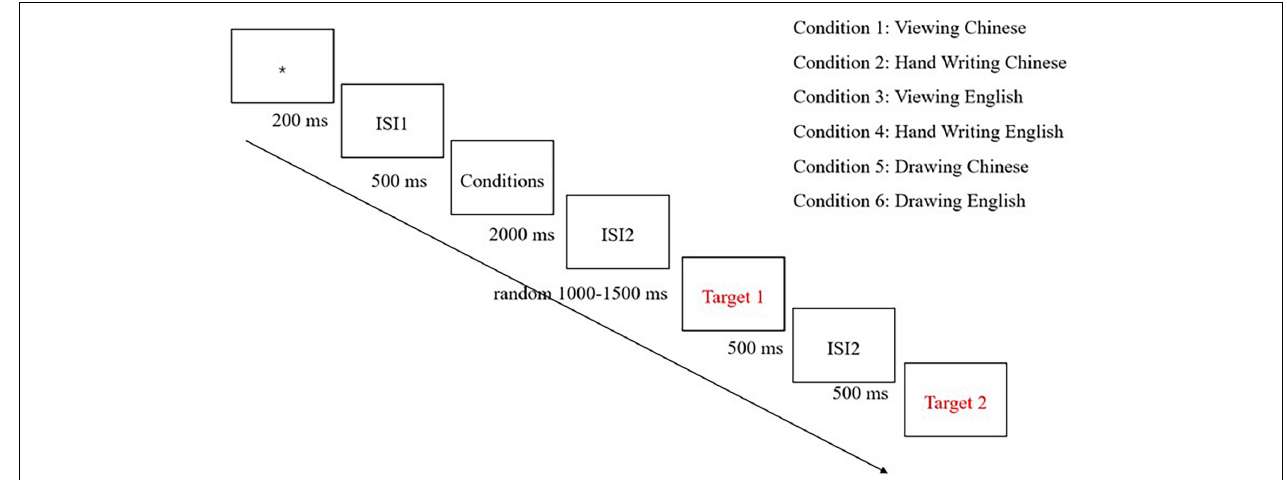
FIGURE 1 | Experimental procedure. *Stands for a fixation asterisk marked the beginning of a trial.